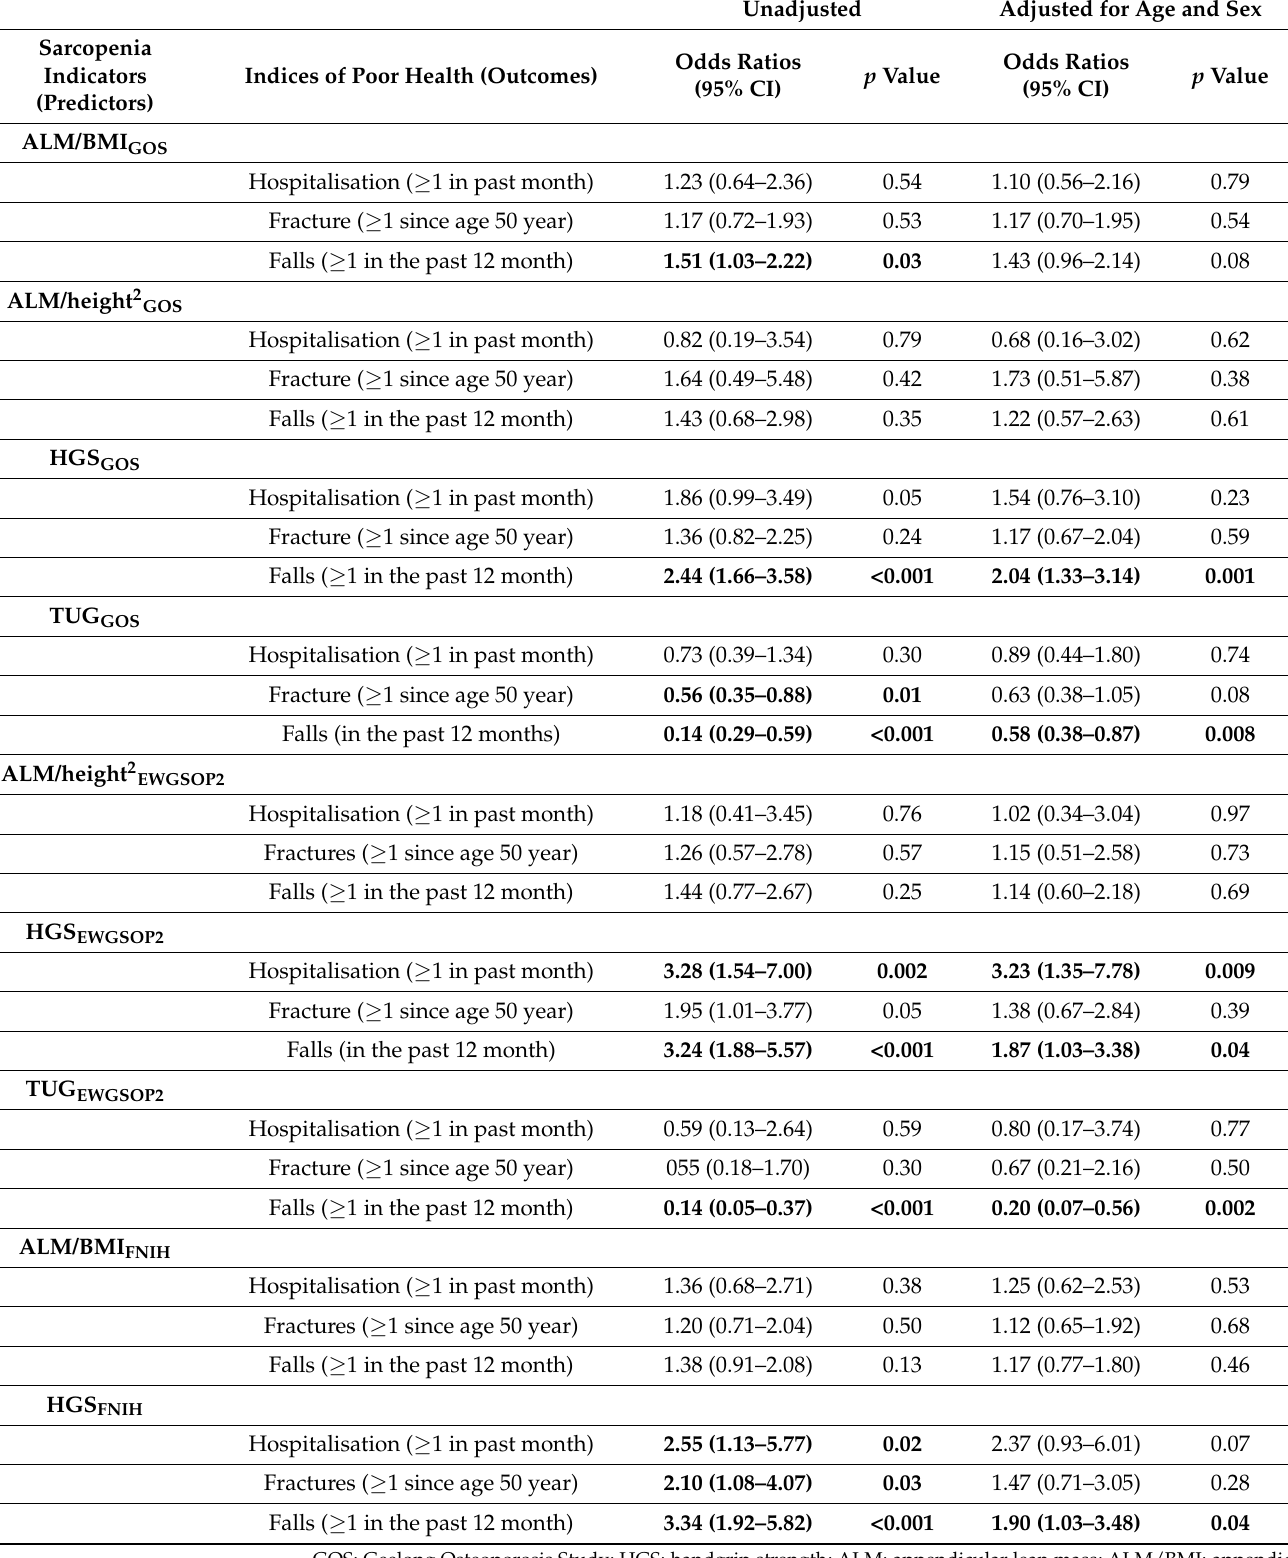
Table 2. Odds ratios (OR 95% confidence interval) of binary logistic models for the associations between low muscle parameters and indices of poor